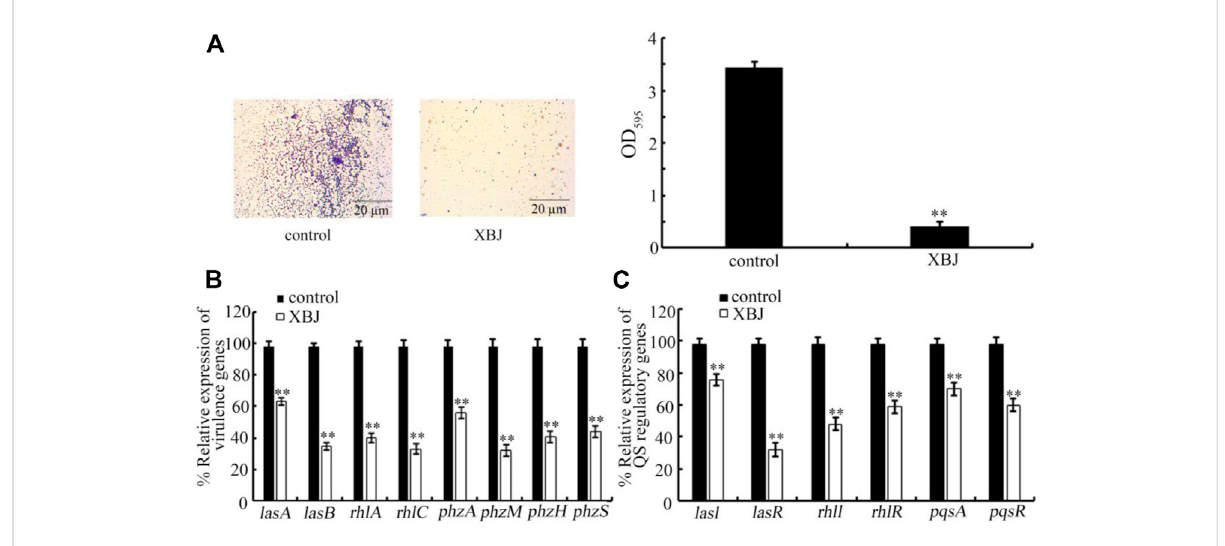
FIGURE 5 Effect of Xuebijing post-treatment on bio fi lm formation (A) , expression of virulence genes (B) , and expression of QS-related genes (C) of PA14. The 100% Xuebijing was used for pharmacological treatment. XBJ, Xuebijing. ** p < 0.01 vs. control.